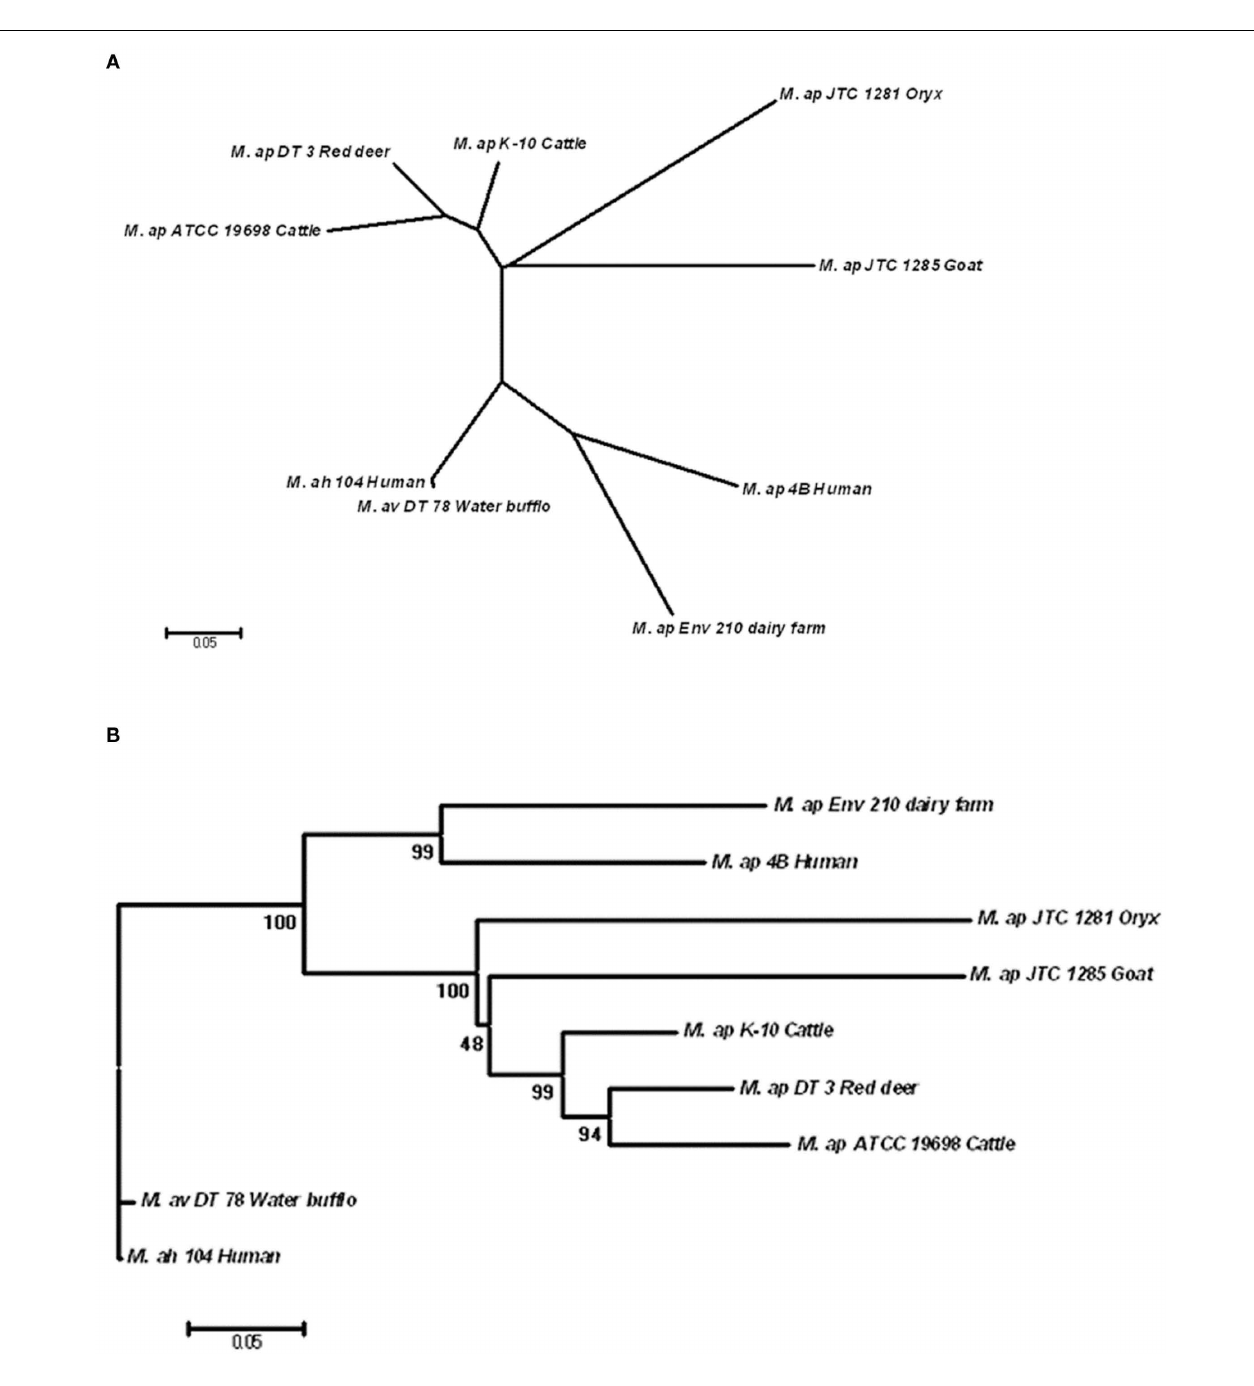
represent the evolutionary history of the taxa analyzed.The bootstrap replicates are marked on each branch and a less than 50% bootstrap replicates were collapsed.The percentage of replicate trees in which the associated taxa clustered together in the bootstrap test is shown next to the